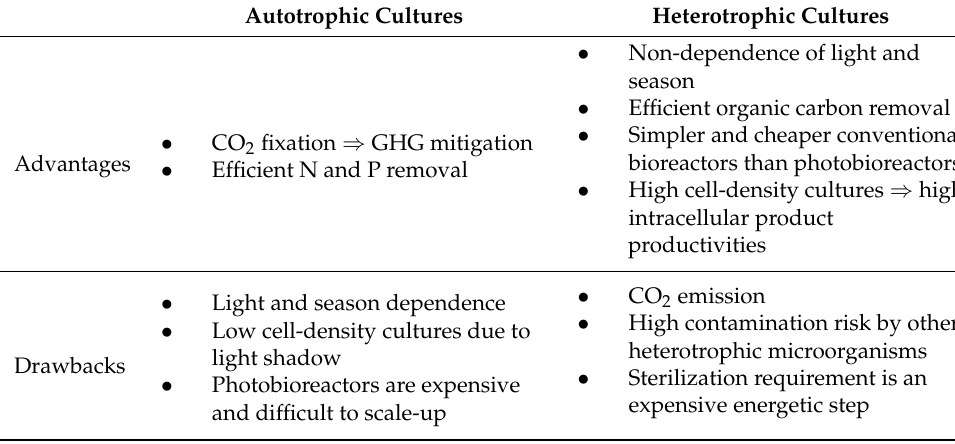
Table 1. Microalgal autotrophic/heterotrophic